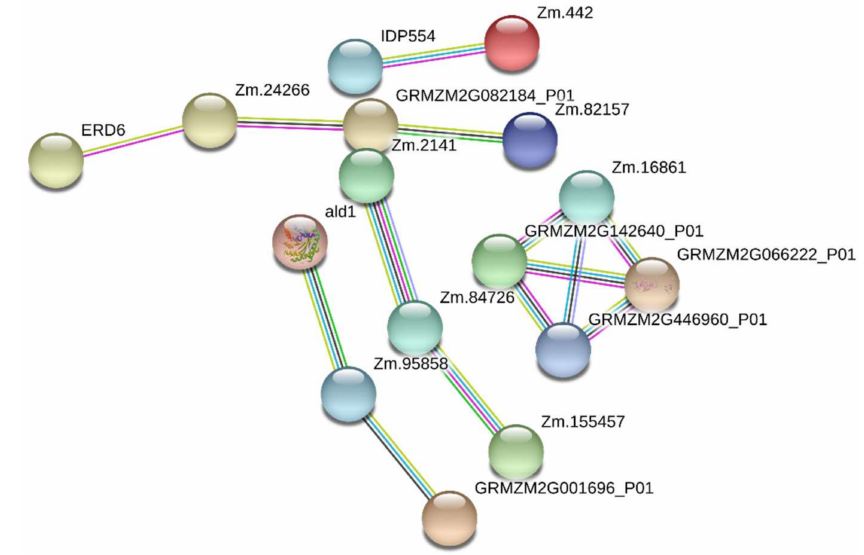
Figure 7. The protein interaction network of DRPPs in Zheng58